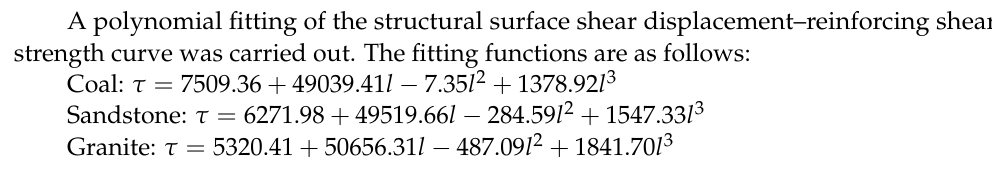
Figure 15. Curves of shear strengths of structural surfaces reinforced by tensile effect of dislocation bolt.